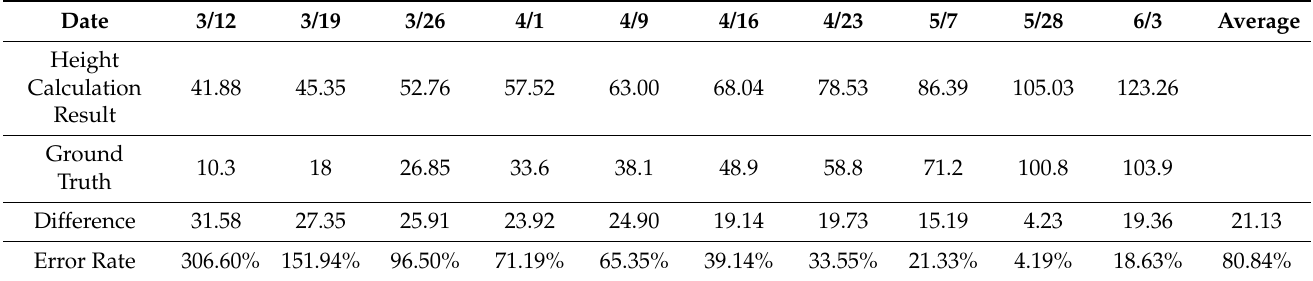
Table 9. Field 3—Comparison of Height Calculation Based on Image and Ground Truth.